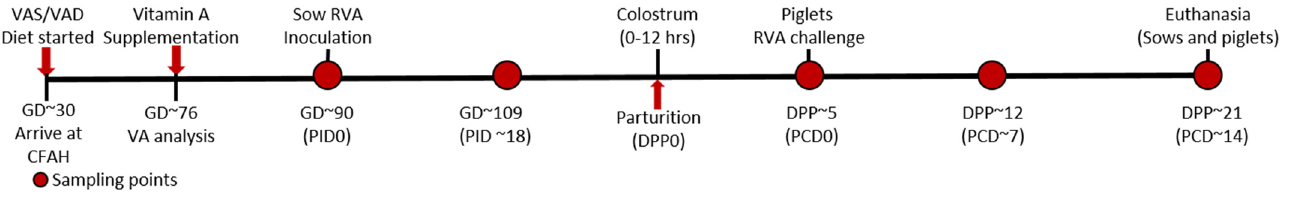
Figure 1. Experimental design to determine the impact of Vitamin A status and RVA inoculation of RVA seropositive pregnant sows on their immune responses and passive protection of their piglets (GD—Gestation Day, PID—Post Inoculation Day, PCD—Post Challenge Day, VAS—Vitamin A sufficient diet, VAD—Vitamin A deficient diet, RVA—rotavirus A) .